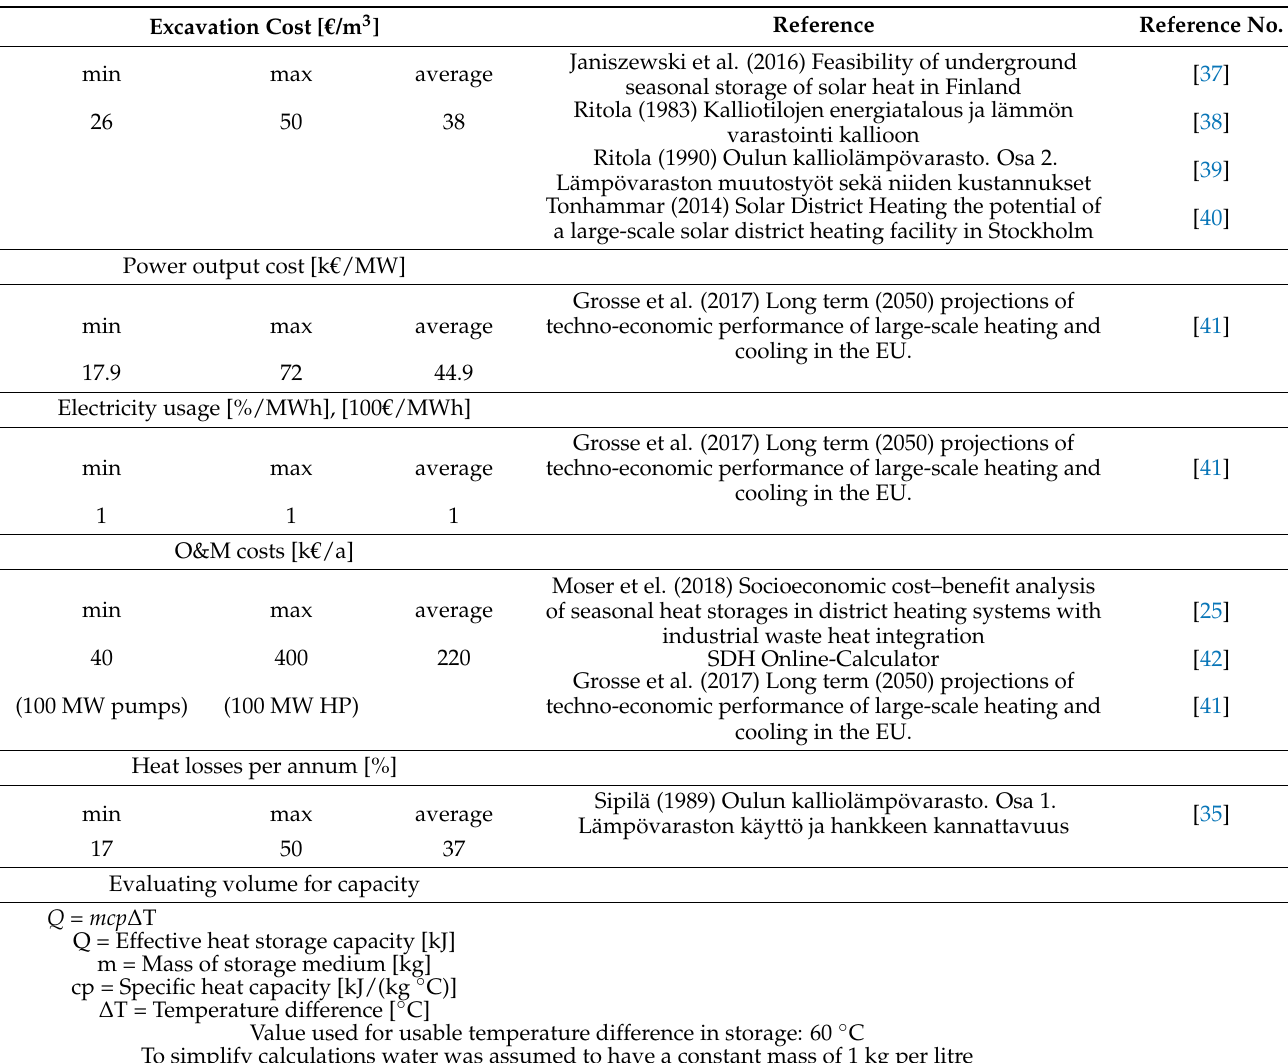
Table A3. Table of values used for seasonal storage investment